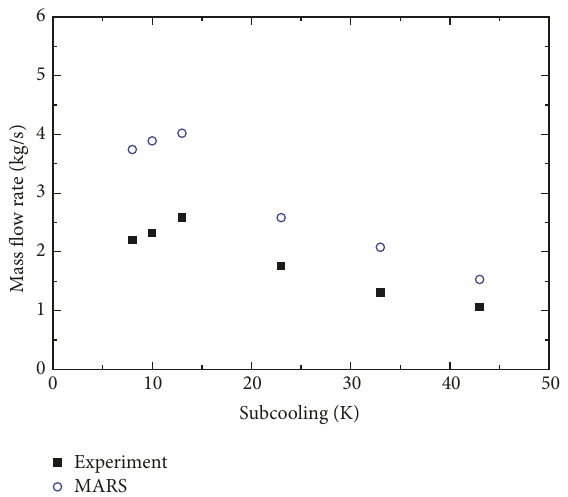
Figure 14: The natural circulation flow rate versus the inlet subcooling.